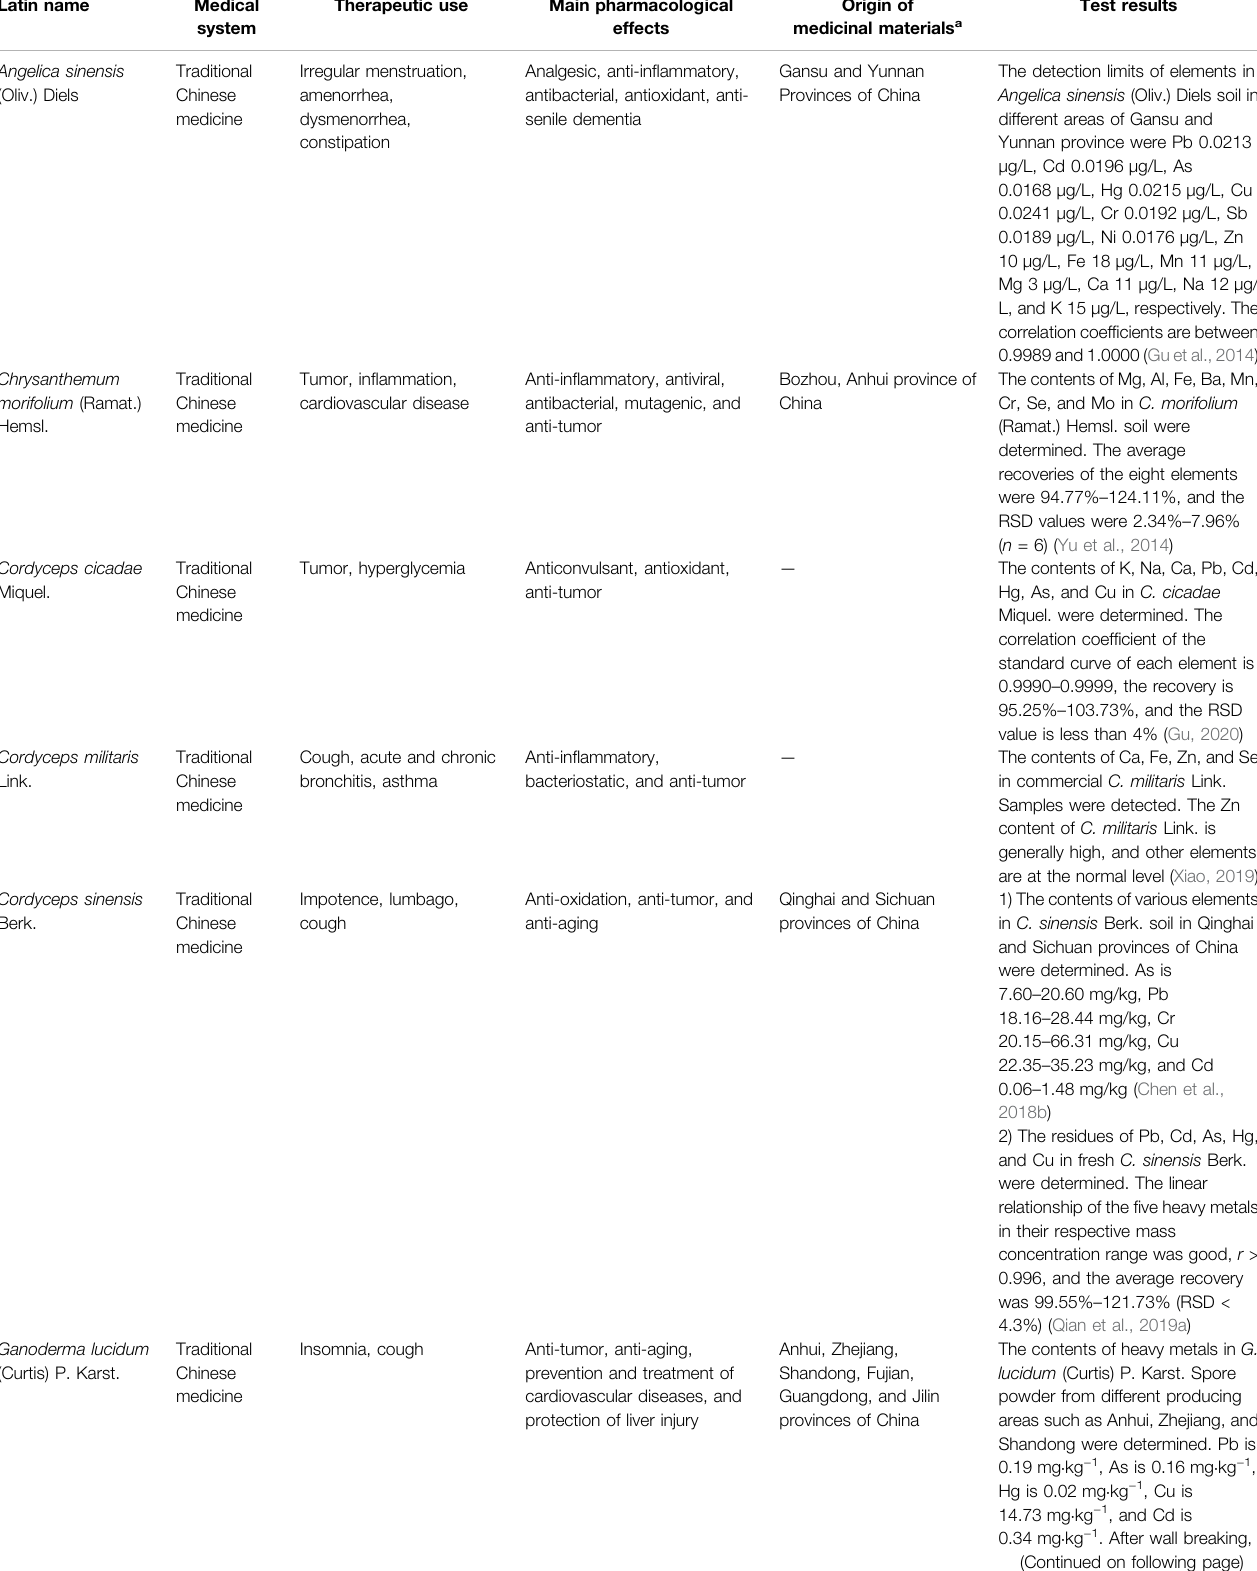
TABLE 7 | Application of ICP-MS in the determination of heavy metal elements in other medicinal materials derived from plants and soil. Latin